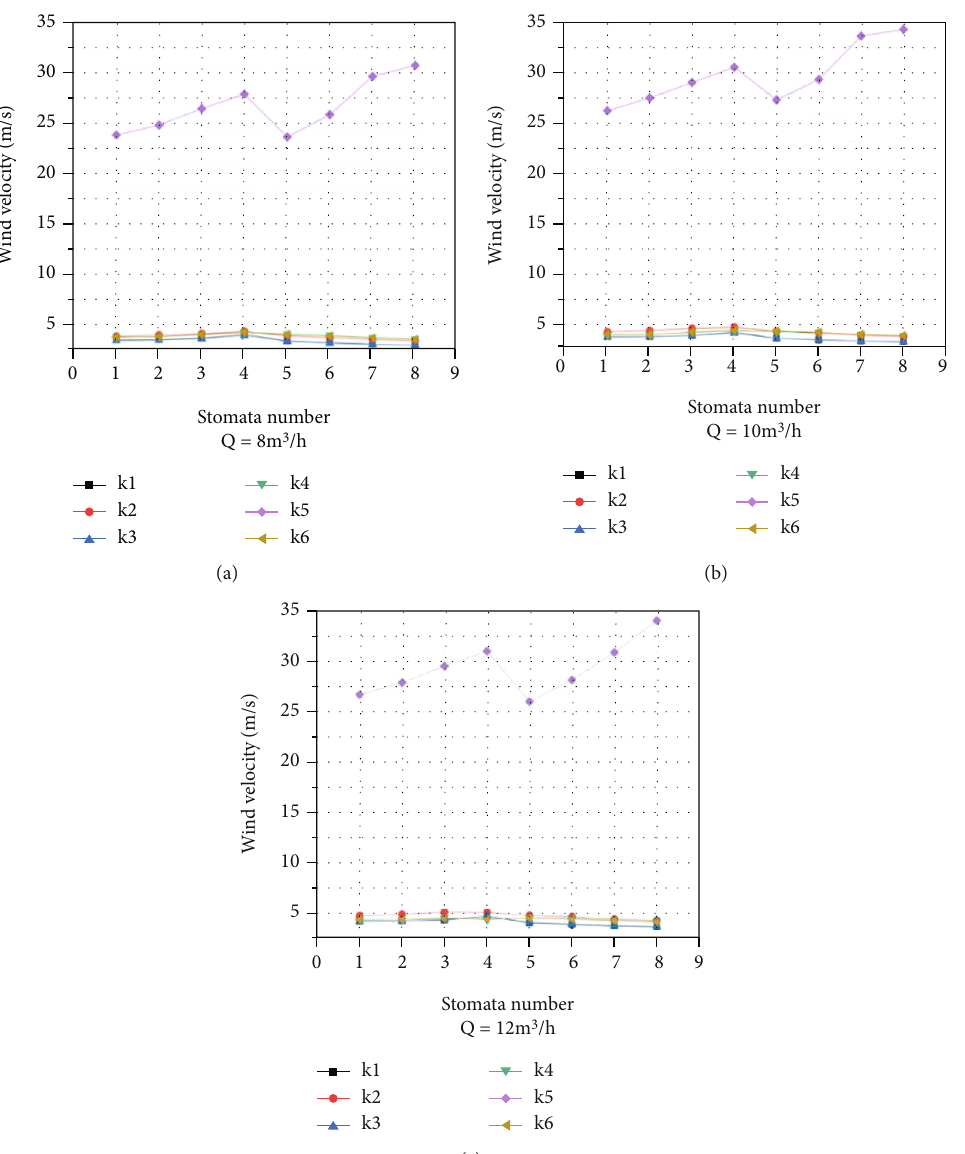
Figure 10: Stomatal wind speed fi gure of longitudinal type: (a) when the ventilation rate is 8 m 3 /h, the stomatal wind speed of each pipeline; (b) when the ventilation rate is 10 m 3 /h, the stomatal wind speed of each pipeline; (c) when the ventilation rate is 12 m 3 /h, the stomatal wind speed of each